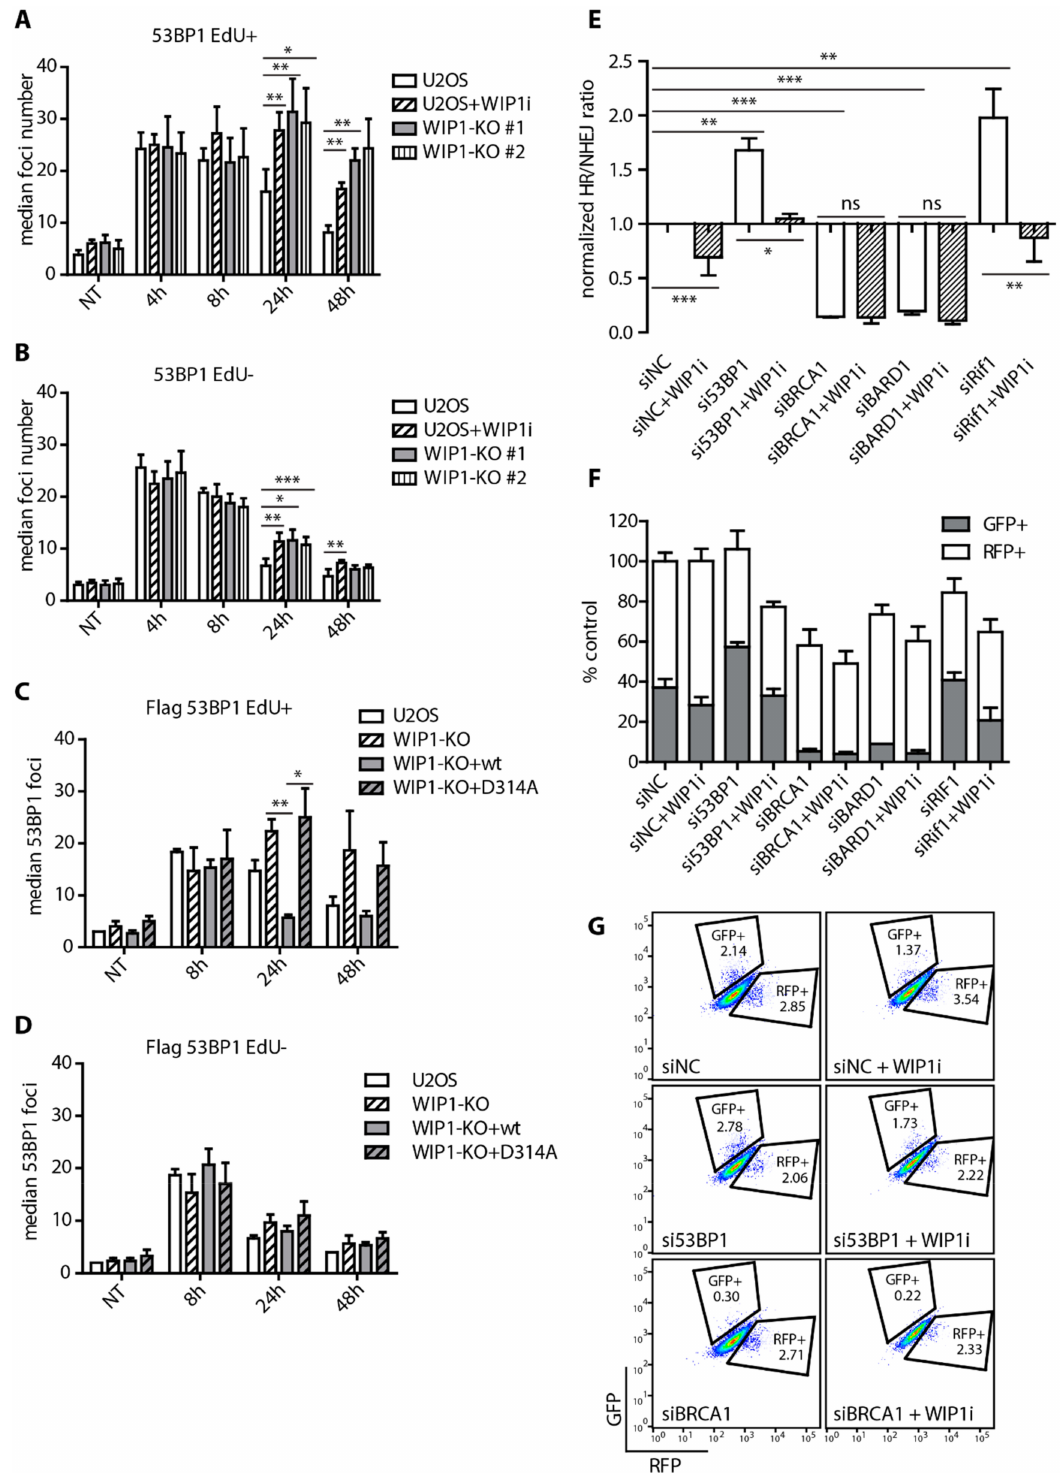
Figure 2. WIP1 plays role in DNA double-strand break repair in S-phase cells. ( A ) Quantification of 53BP1 foci in replicating (EdU + ) cells after irradiation. U2OS parental cell lines with or without combined treatment with WIP1i and two independent WIP1 knockout cell lines were pulse-labeled with EdU for 30 min before irradiation. Cells were fixed after pre-extraction at indicated time-points and stained with 53BP1 antibody. Click chemistry was used to visualize EdU. Mean of median foci number +/ - SD is plotted (n ≥